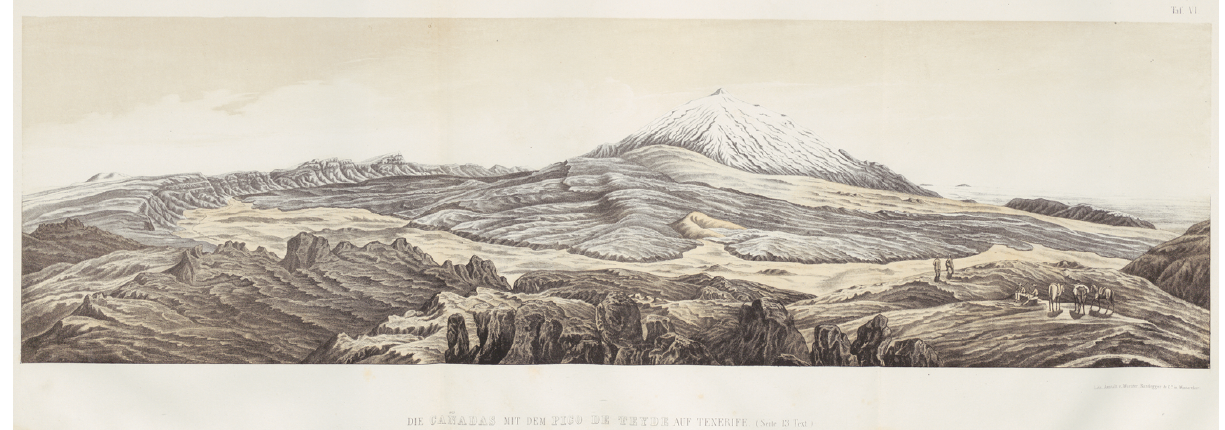
Figure 8. A Hartung drawing in Fritsch (1867), plate VI, portraying a view from Las Cañadas into the Mount Teide stratovolcano in Tenerife, Canary Islands. A similar drawing was published in Lyell (1855, p. 514; Fig. 651), where credit is given to Georg Hartung. The image is public domain and was digitalized by ETH-Bibliothek Zurich (https://www.e-rara.ch/zut/content/zoom/6096244, last access: 26 September